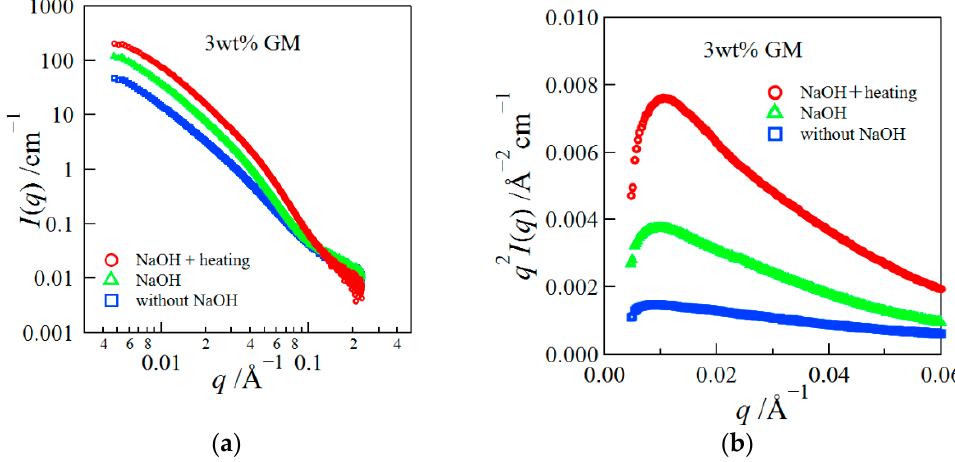
Figure 2. SAXS profiles for GM gels prepared in the various methods ( a ) and the Kratky plot ( b